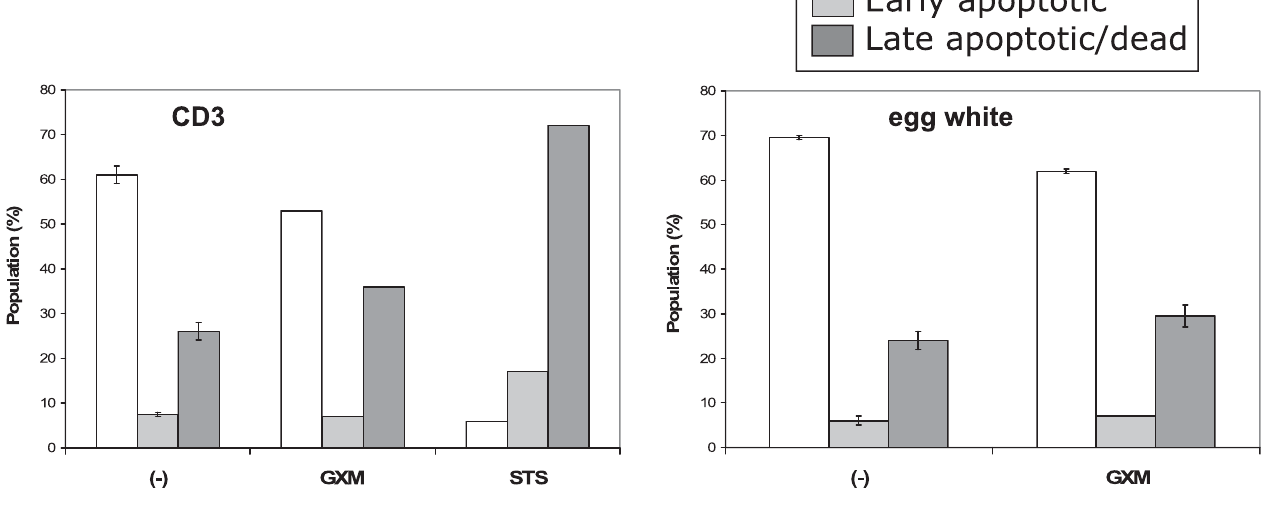
Figure 5. Effect of GXM on T-Cell Viability Purified CD4 þ T cells from OT-II mice were activated with anti-CD3 e antibody or BMDC plus egg white. Cells were left untreated ( (cid:1) ) or treated with GXM (300 l g/ml) or staurosporine (STS). At 48 h, T cells were stained with Annexin V/FITC and PI and analyzed by flow cytometry. Annexin (cid:1) PI (cid:1) cells are defined as live, Annexin þ PI (cid:1) as early apoptotic, and Annexin þ PI þ as late apoptotic or dead. Data are expressed as mean 6 SEM of one experiment (representative of three) done in duplicate (except